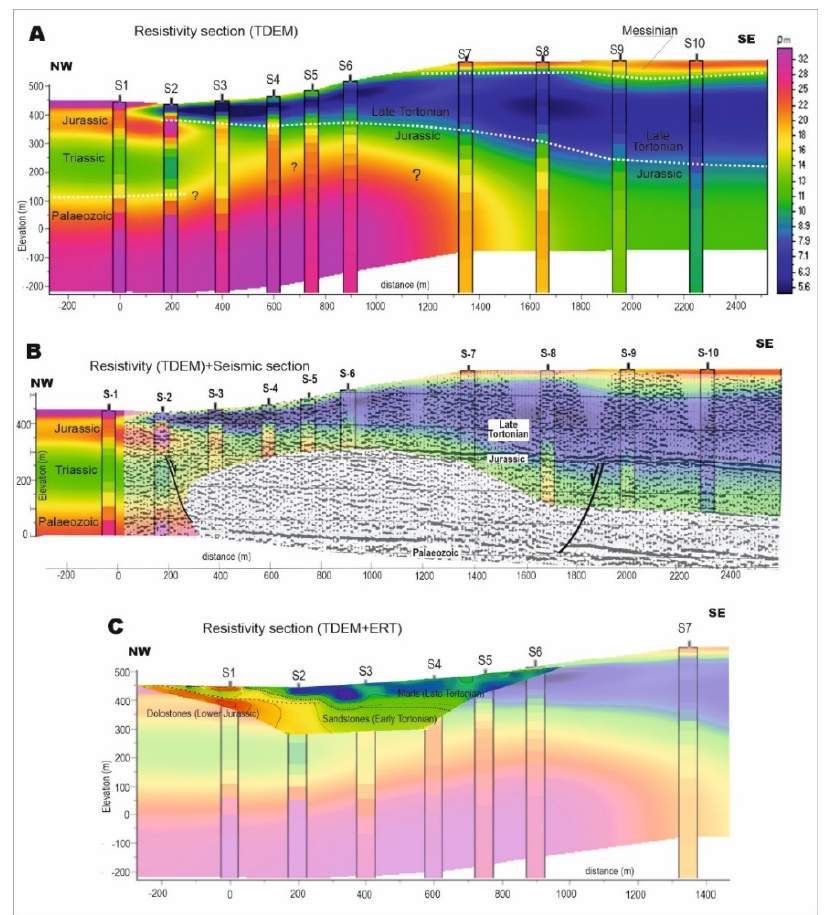
Figure 7. 2D section showing resistivity distribution as a result of smooth-model inversion implemented in the program ZondTEM2D ( A ). Seismic reflection profile and TDEM section correlation ( B ). Correlation of seismic reflection and electrical resistivity tomography ( C ).